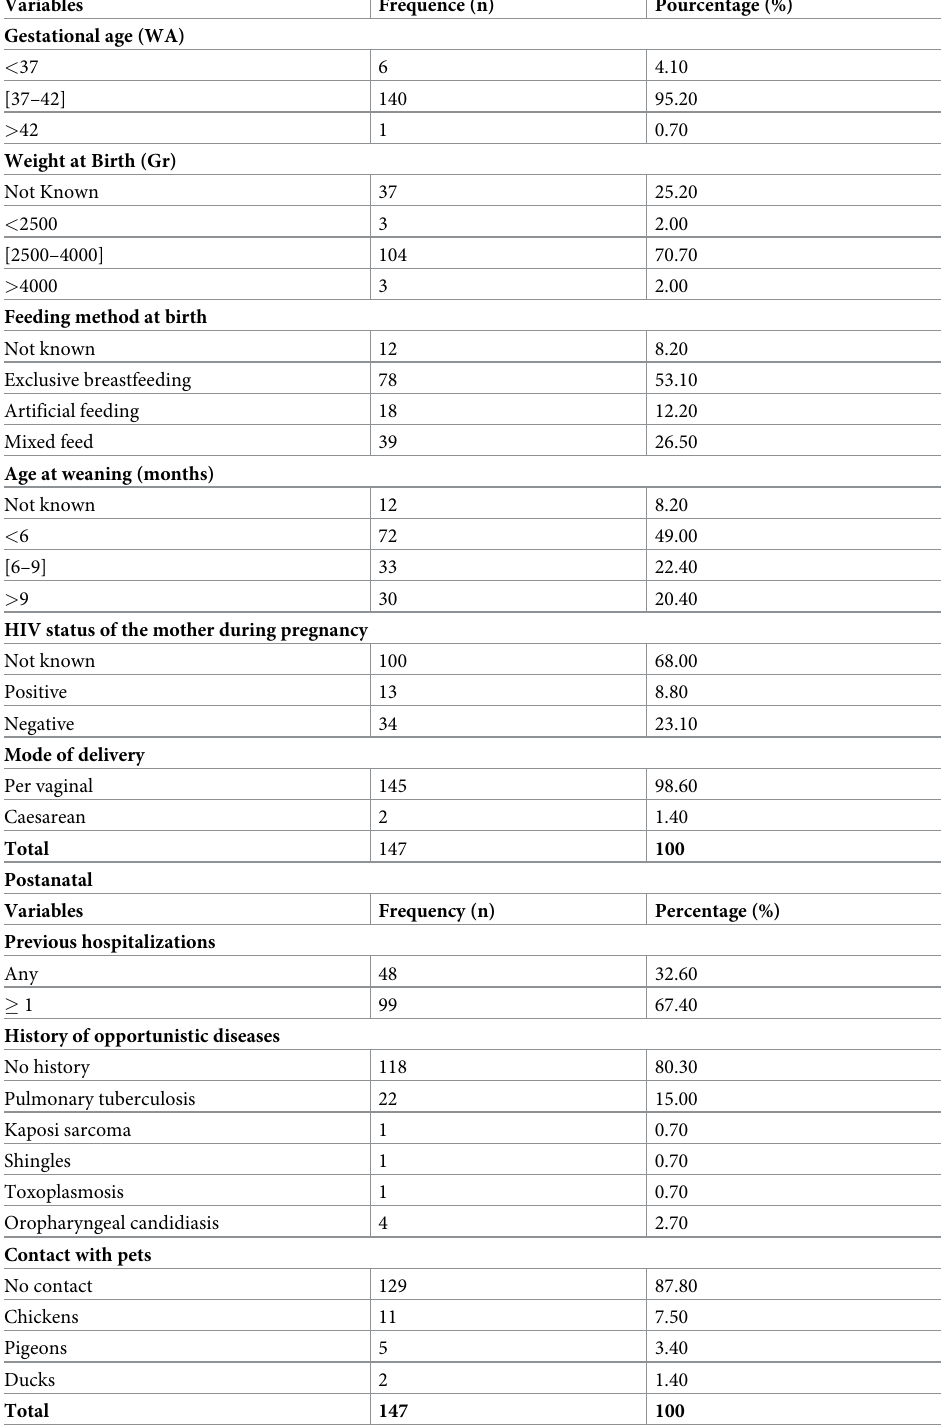
Table 2. Perinatal and postnatal history of mothers and